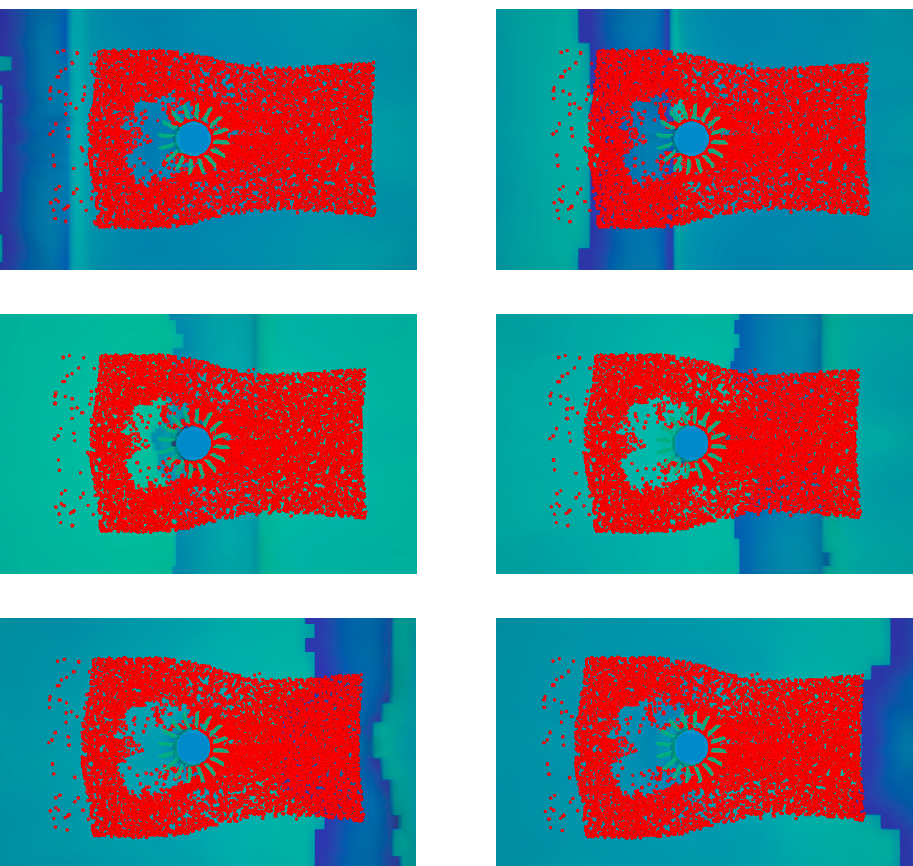
Figure 25. Sequential snapshots of the bed morphology as the waves proceeded by the hybrid monopile.